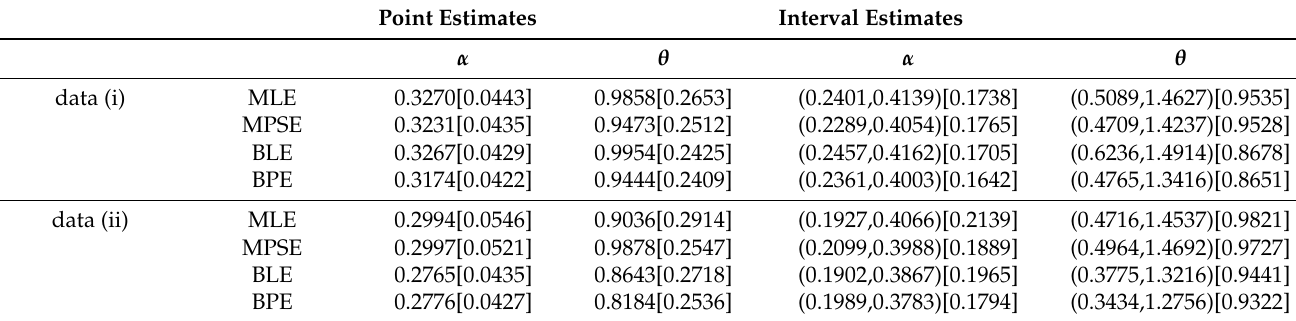
Table 7. Point and interval estimates of α and θ under real-world